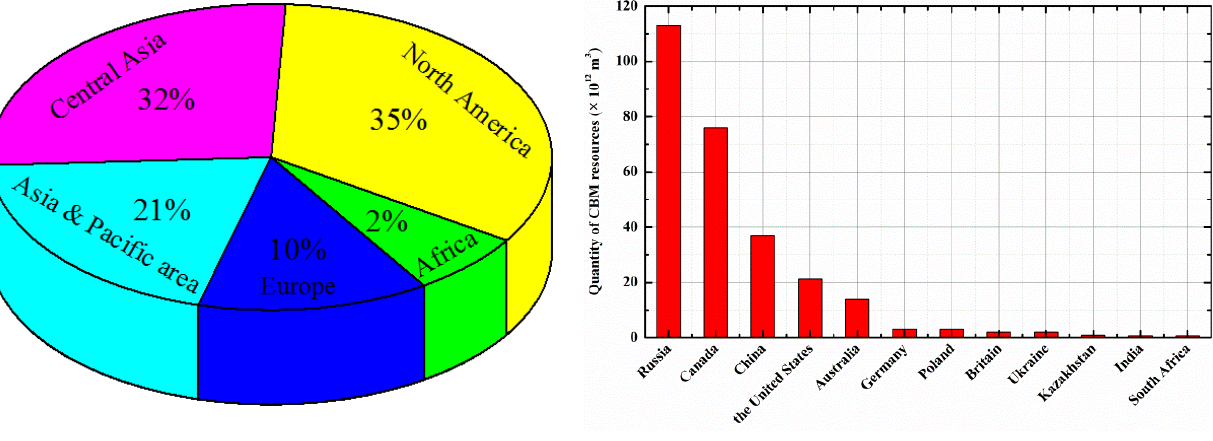
Figure 1. Distribution of global CBM resources.